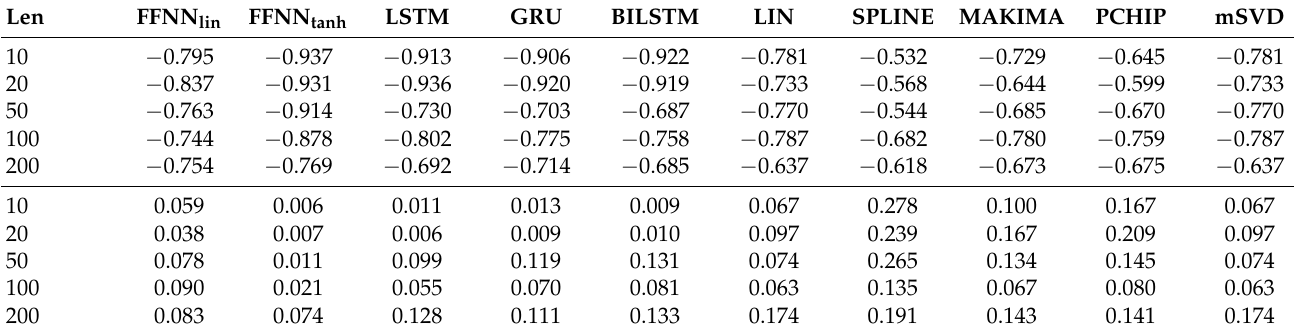
Table A12. Correlation between RMSE and complexity of input